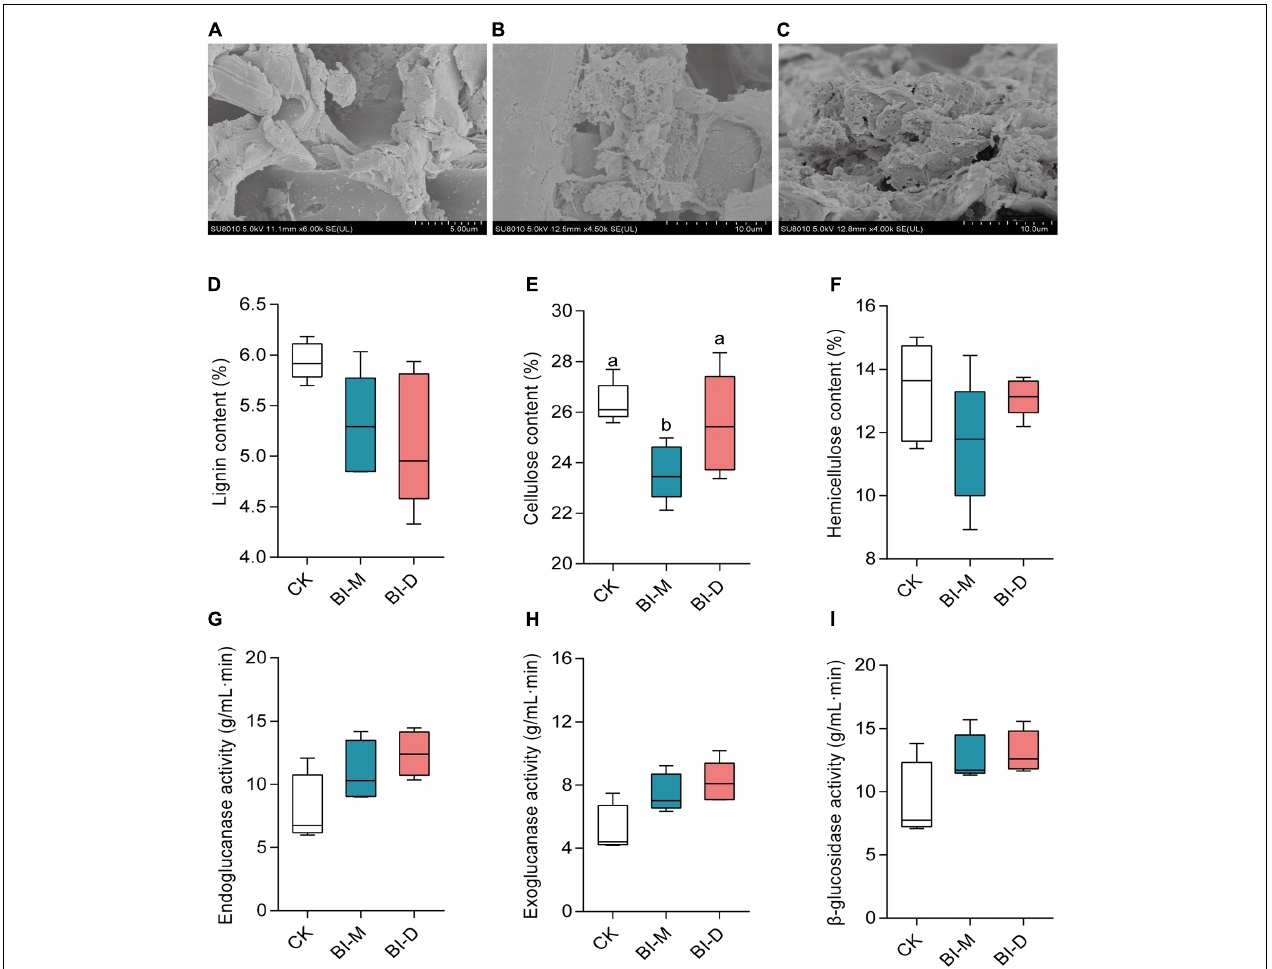
FIGURE 4 | In vitro maize cellulose degradation by microbial consortia BI-D and BI-M. Scanning electron micrographs of (A) untreated maize particles, (B) maize particles treated by BI-D for 9 days, and (C) maize particles treated by BI-M for 9 days. The content of (D) lignin, (E) cellulose and (F) hemicellulose in maize particles after treated for 9 days. The cellulose-associated enzyme activity of (G) endoglucanase, (H) exoglucanase, and (I) β -glucosidase in the culture medium of maize particles treated with BI-D and BI-M for 9 days. Horizontal lines in the boxes represent group medians, and whiskers represent the 10th–90th percentiles. Superscripts (a, b) indicate significant differences between different groups ( P <